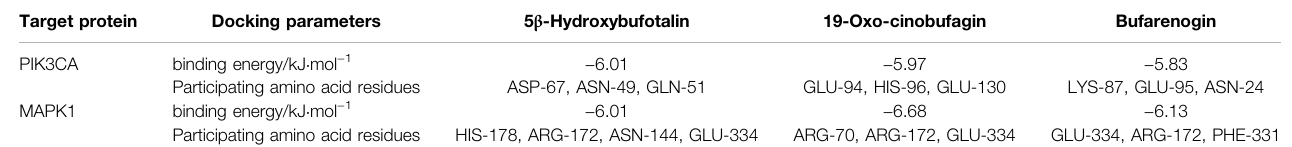
TABLE 3 | Molecular docking parameter table.